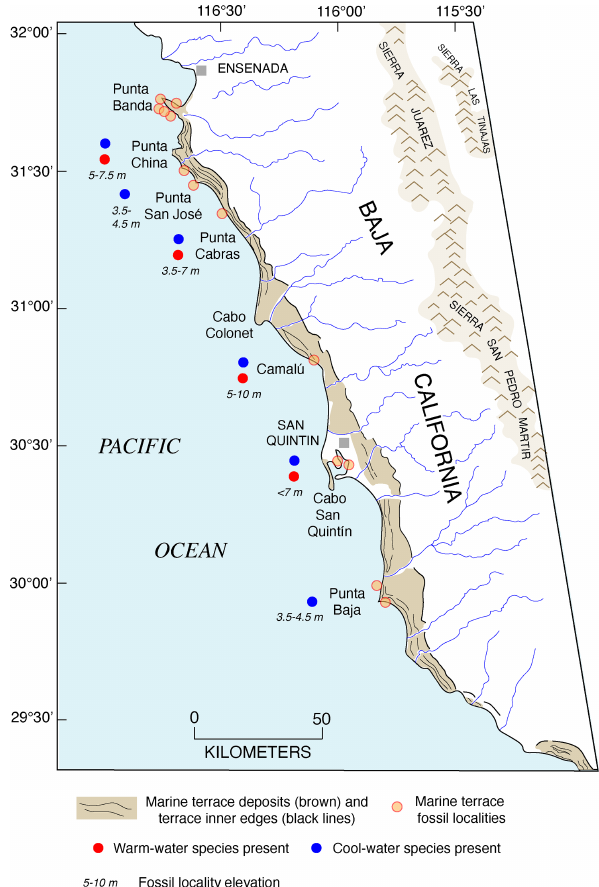
Figure 30. Map of northwestern Baja California, showing marine terrace deposits (brown shades), terrace inner edges (black lines), and fossil localities (red–orange circles). Punta Banda fossil locali- ties are shown in Fig. 31. South of Punta Banda, most fossil local- ities are undated, but based on elevations shown here, many likely date to some part of MIS 5 and could contain mixes of fossils of two ages, with cool-water (blue dots) and warm-water (red dots) faunas (see text for discussion). Marine terrace deposits and inner edge mapping redrawn from Orme (1980).